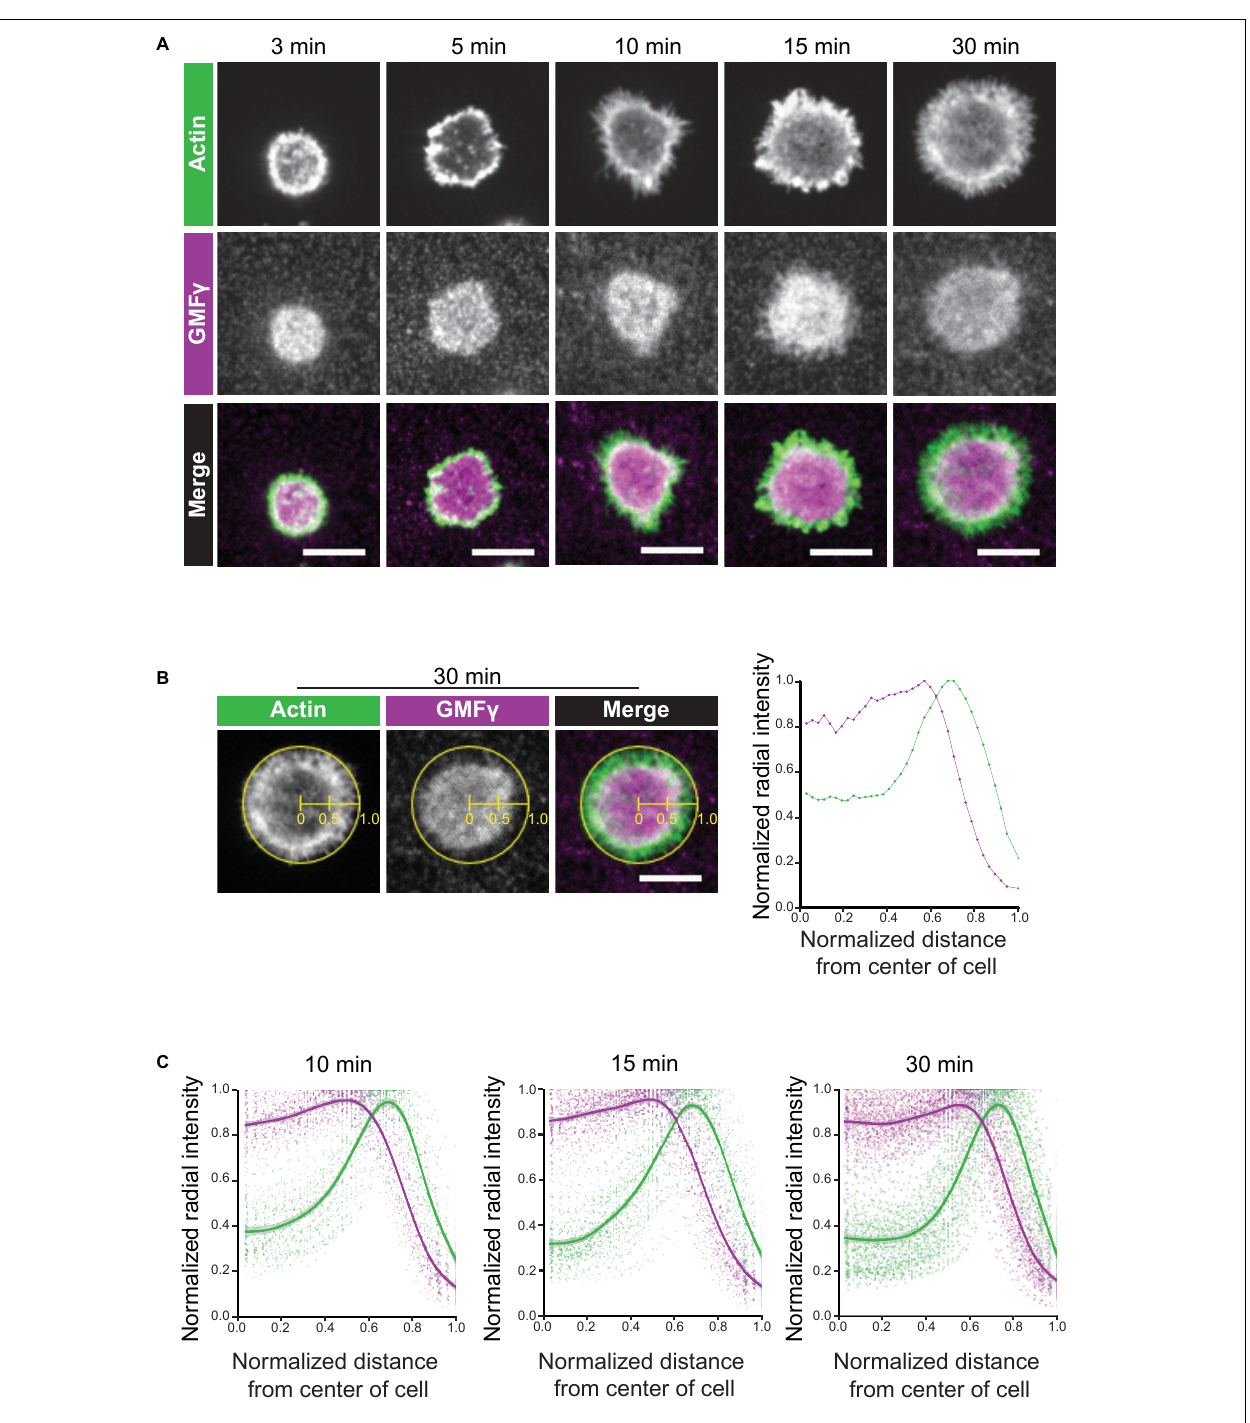
FIGURE 3 | GMF γ abuts the inner face of the peripheral actin ring. Ramos B cells were allowed to spread for 3–30 min on anti-IgM-coated coverslips before being stained with an anti-GMF γ antibody plus rhodamine-phalloidin. (A) Representative confocal microscopy images. Scale bars: 10 µ m. (B) Example of actin and GMF γ radial fluorescence intensity profiles for an individual cell. The ImageJ Radial Profile Extended plug-in generates concentric circles with radii corresponding to different distances from the center of the cell and then calculates the average fluorescence intensity per pixel around the perimeter of each circle. This integrated radial intensity value is normalized to the maximal value for any circle from that cell (defined as 1.0) and is plotted vs. its relative distance between the center of the cell ( x = 0) and the edge of the cell ( x = 1). The graph (right panel) shows the radial intensity profiles for GMF γ (purple) and F-actin (green) for the cell shown in the left three panels, which had spread on immobilized anti-IgM for 30 min. (C) The averaged radial fluorescence intensity profiles for 78–129 cells per time point are shown for cells that had spread on anti-IgM for 10, 15, or 30 min in one of 4 independent experiments. For each relative distance, the dots are the values for individual cells. The solid lines and corresponding gray contours are the generalized additive model and standard error of the smoothing estimate.